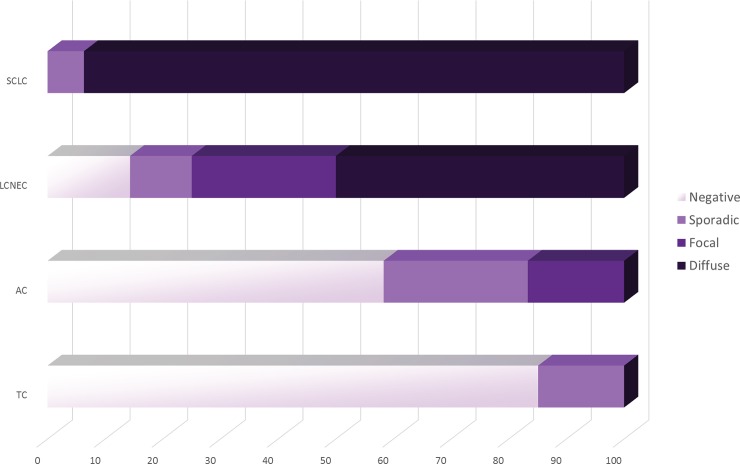
Analysis of p16Ink4A overexpression in neuroendocrine lung tumors reveals an increase in the proportion of positive neoplastic cells within each tumor histotype moving from lower to higher grade malignancies.Each bar represents a histotype, as indicated on the left; the specific patterns of p16Ink4A immunoexpression are color-coded on the basis of the legend on the right. TC: typical carcinoid; AC: atypical carcinoid; LCNEC: large cell neuroendocrine carcinoma; SCLC: small cell carcinoma.